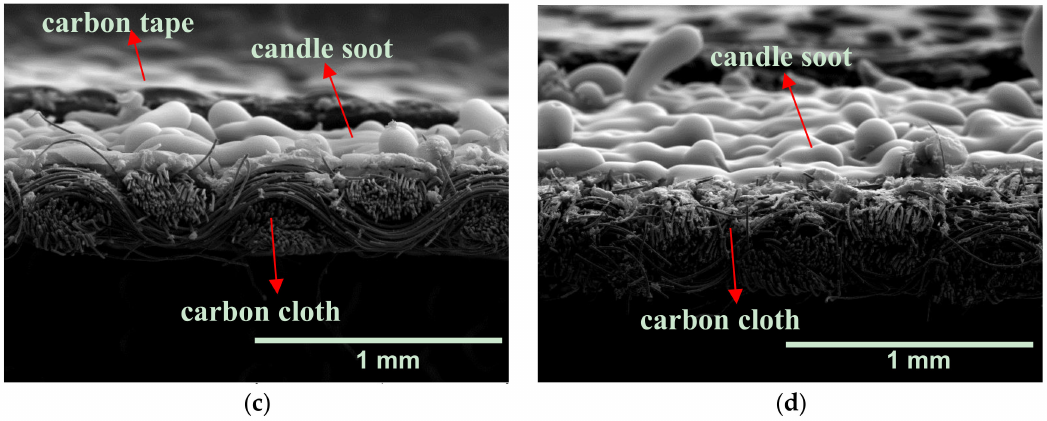
Figure 3. Cross-sectional SEM images of the ( a ) unmodified carbon cloth and those modified by candle sooting for ( b ) 20 s, ( c ) 60 s, and ( d ) 120 s.